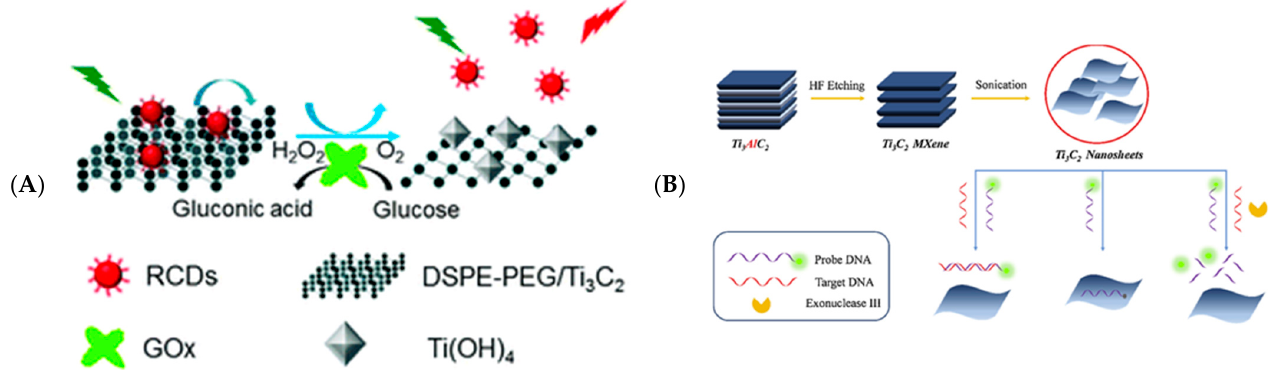
Figure 9. ( A ) Schematic diagram of MXene-based glucose oxidase fluorescent biosensor. Reprinted with permission from Ref. [94]. Copyright 2019, Royal Society of Chemistry. ( B ) Illustration of analysis of HPV-18 type DNA using Ti 3 C 2 MXene. Reprinted with permission from Ref. [95]. Copyright 2019, Elsevier.